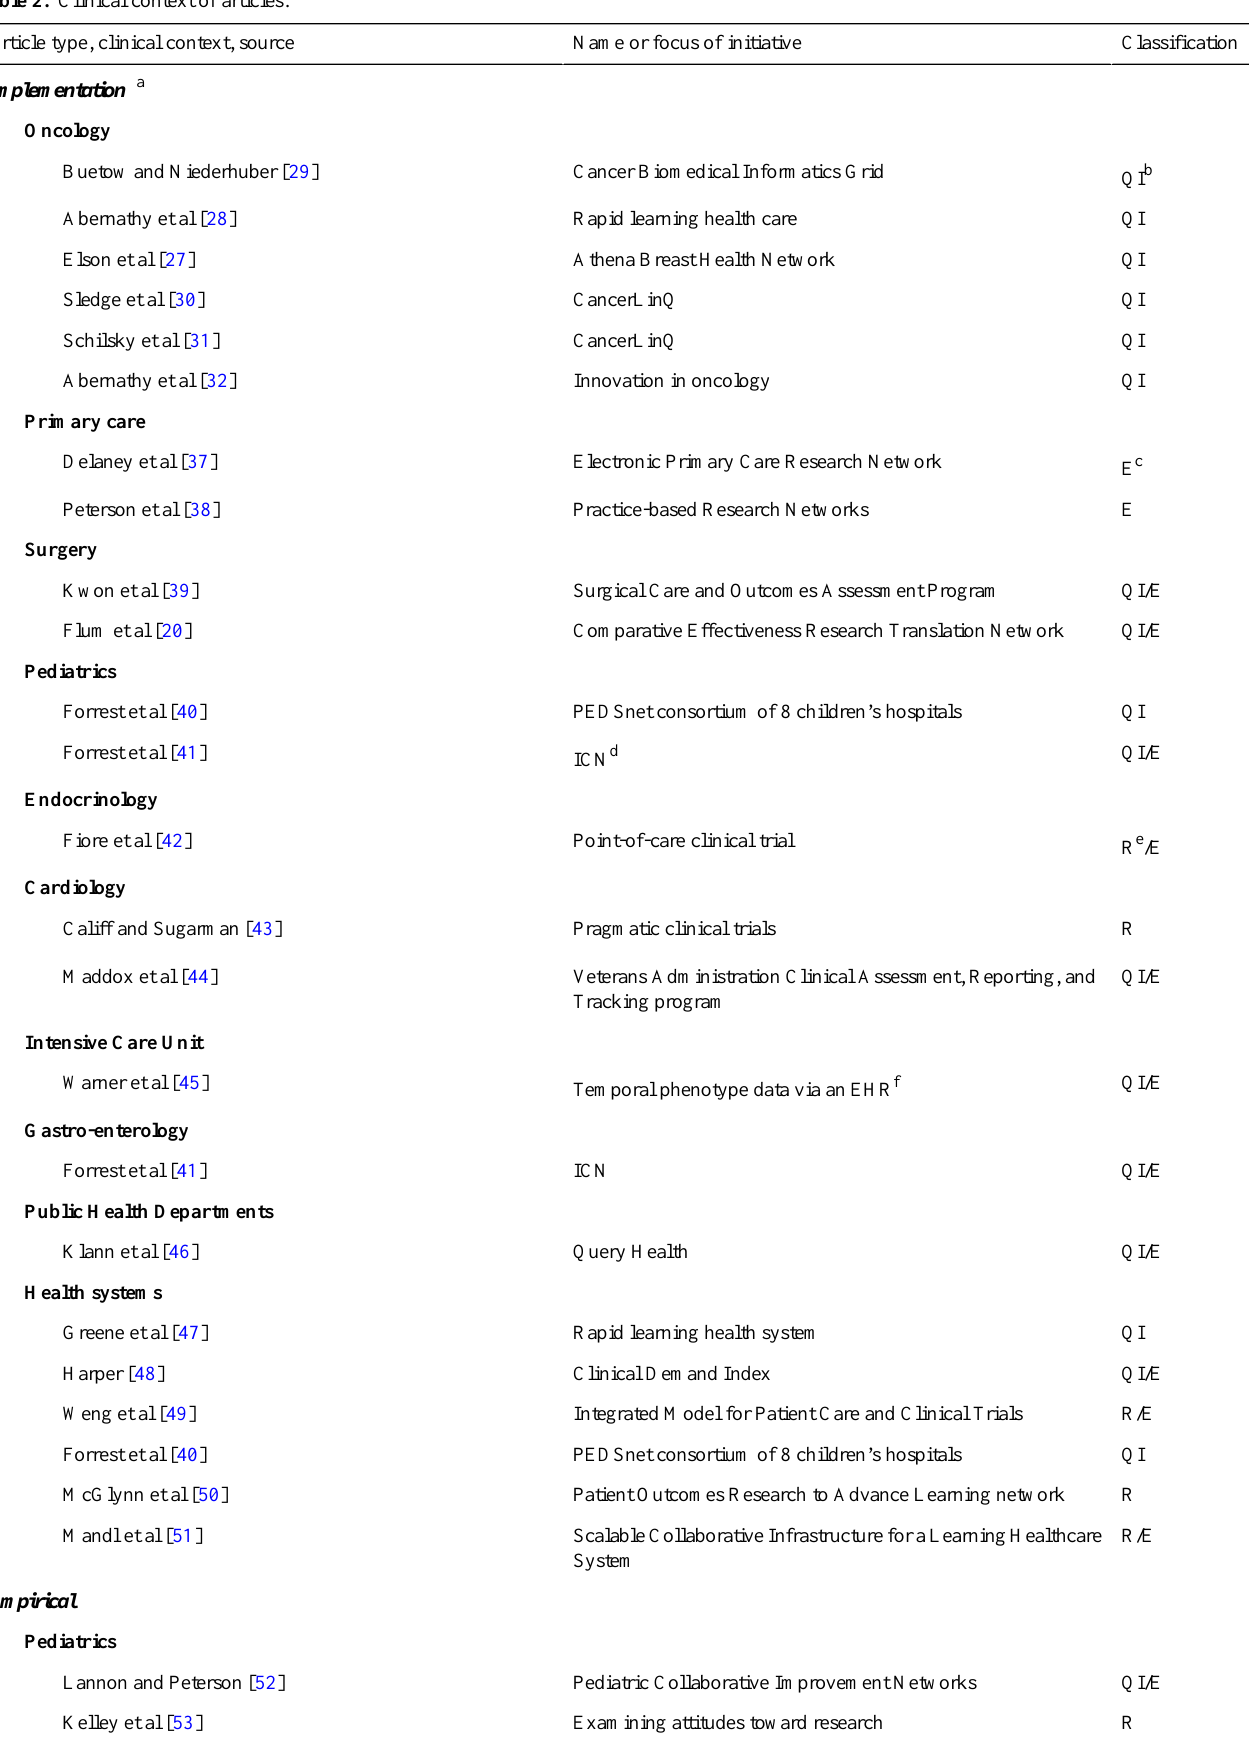
Table 2. Clinical context of articles.